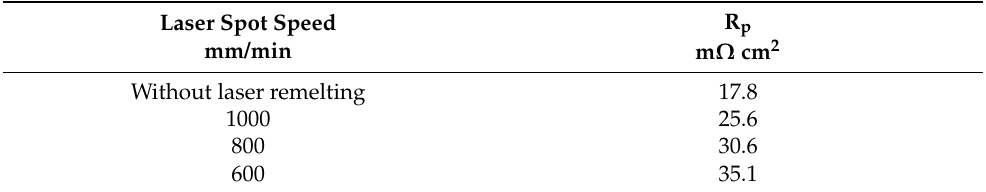
Table 4. Polarization resistance of the Cr 3 C 2 -25(Ni20Cr) cermet coatings on the Al7075 substrate without and with laser